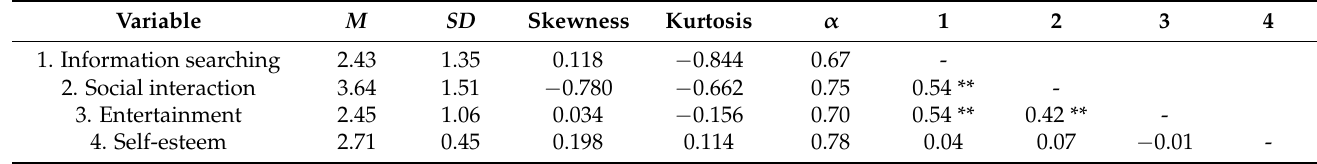
Table 2. Descriptive statistics and correlations of all variables.